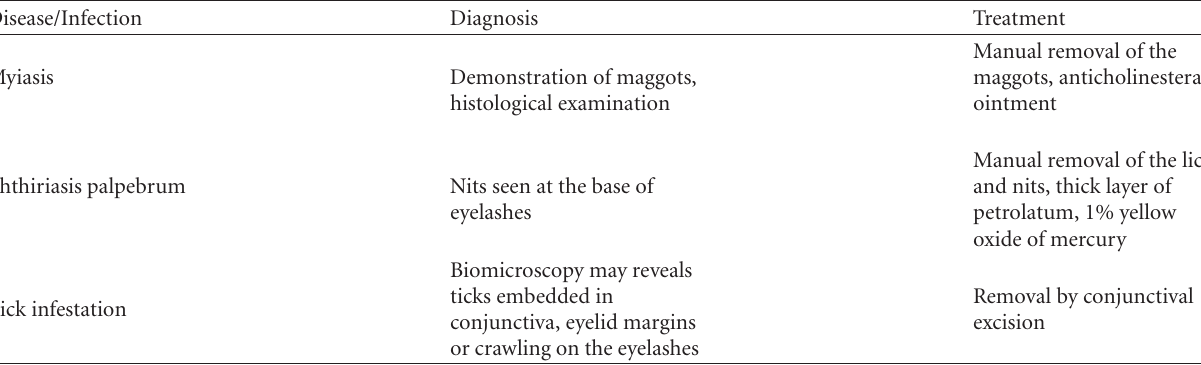
Table 8: Ocular parasitosis caused by ectoparasites ( diagnosis and treatment